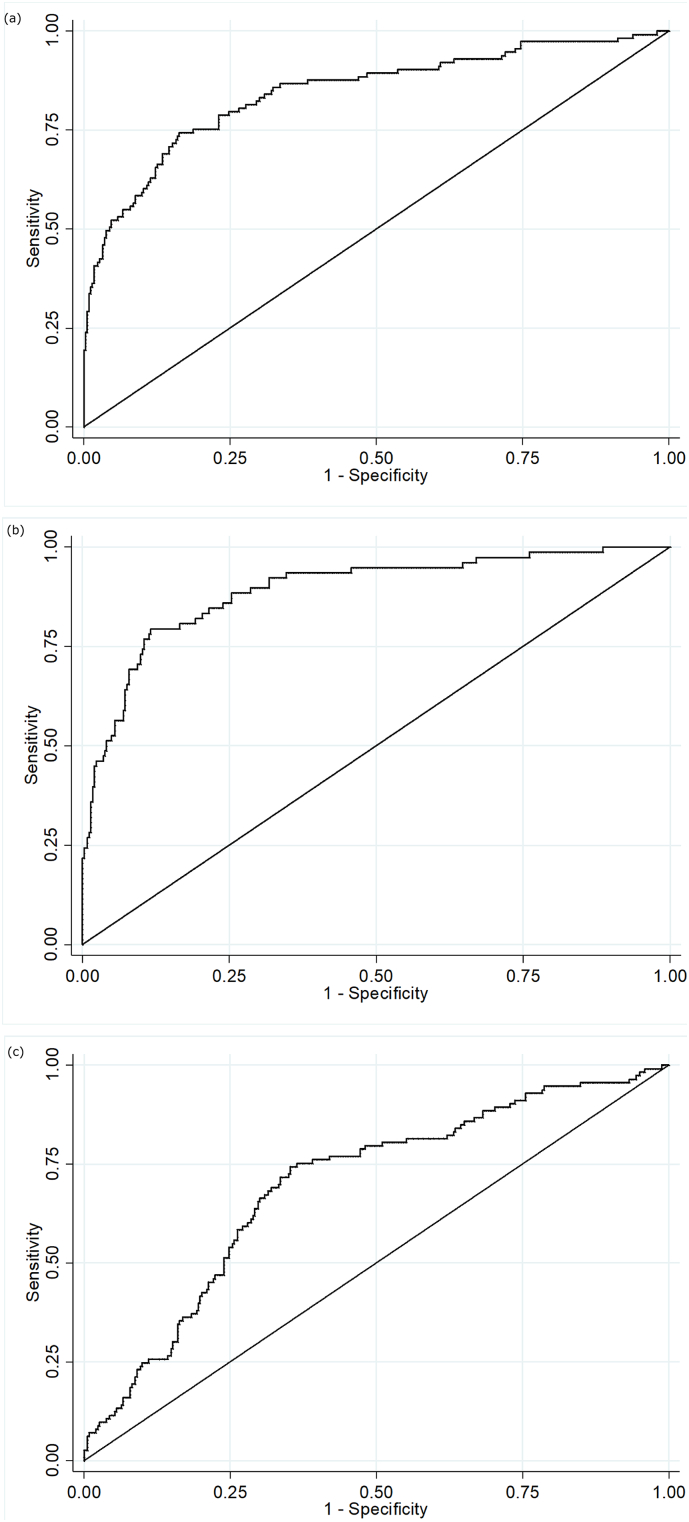
ROC curves for final fitted predictive models (after multiple imputation).A = Model 1 Neoplasia vs control; B = Model 2 Dysplasia vs control; C = Model 3 Matched non-neoplastic vs control. X-axis = 1-specificity; Y-axis = Sensitivity.